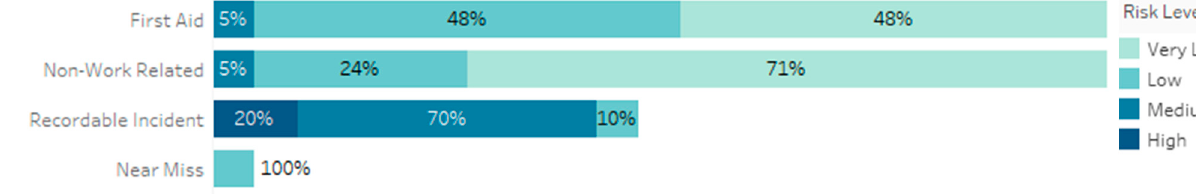
Figure 6. Percentage of injuries by incident classification.